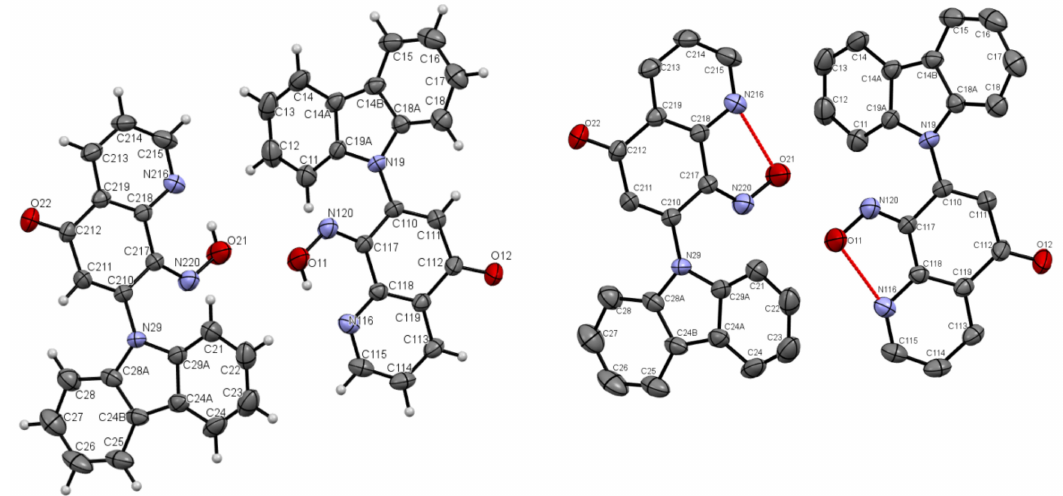
Figure 5. ORTEP drawings of compound 5b with 30% probability ( left ). ORTEP drawings of compound 5b with 30% probability with hydrogen bonds ( right